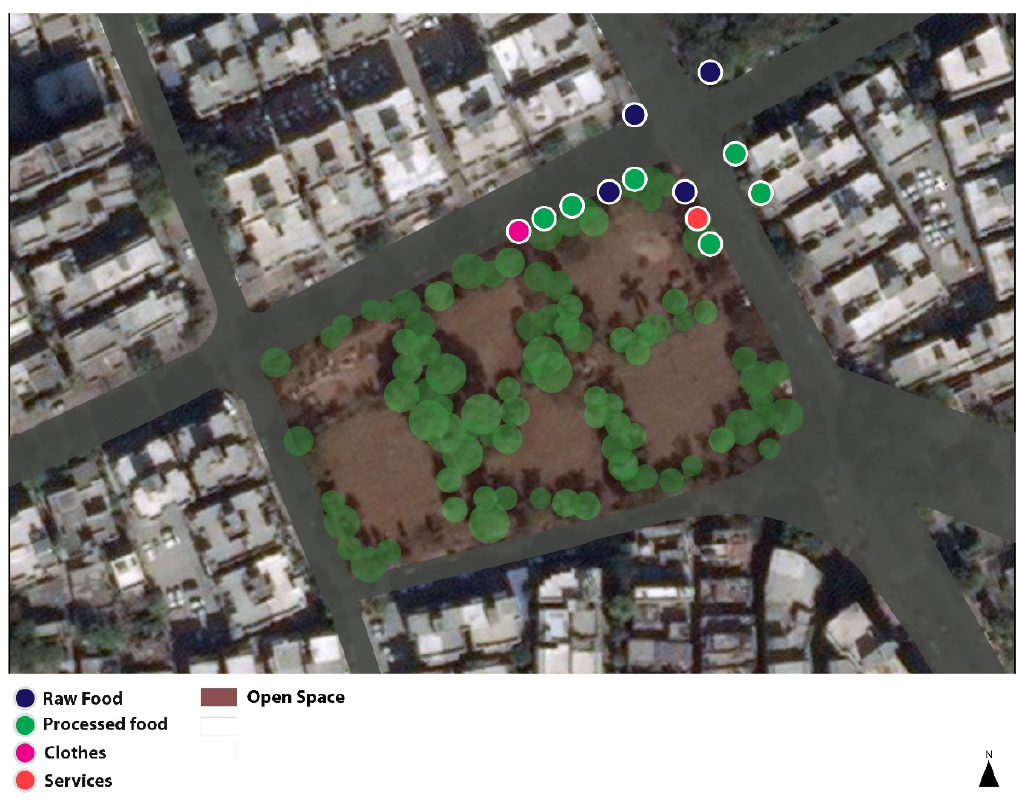
Figure 6. Street market at Law Garden. Source: Field